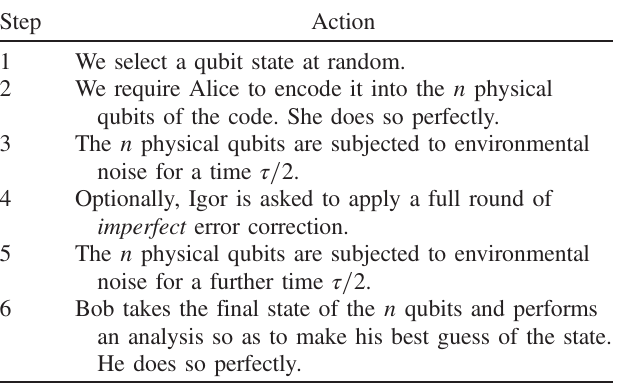
TABLE I. Protocol for assessing the beneficial role of